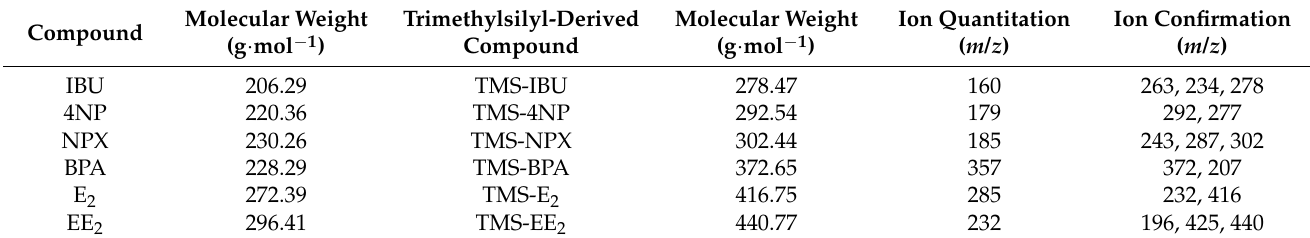
Table 1. Monitored ions ( m / z ) in mass spectrometry for each of the trimethylsilyl-derived (TMS) compounds of